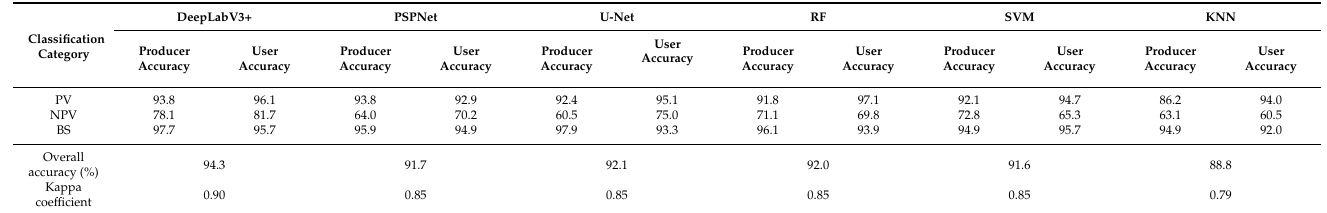
Table 4. Classification accuracy of PV, NPV, and BS under different classification